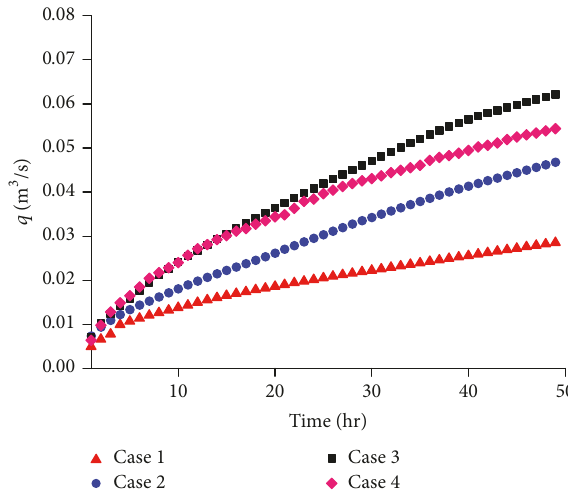
Figure 13: Evolution of the total net flow into the unsaturated